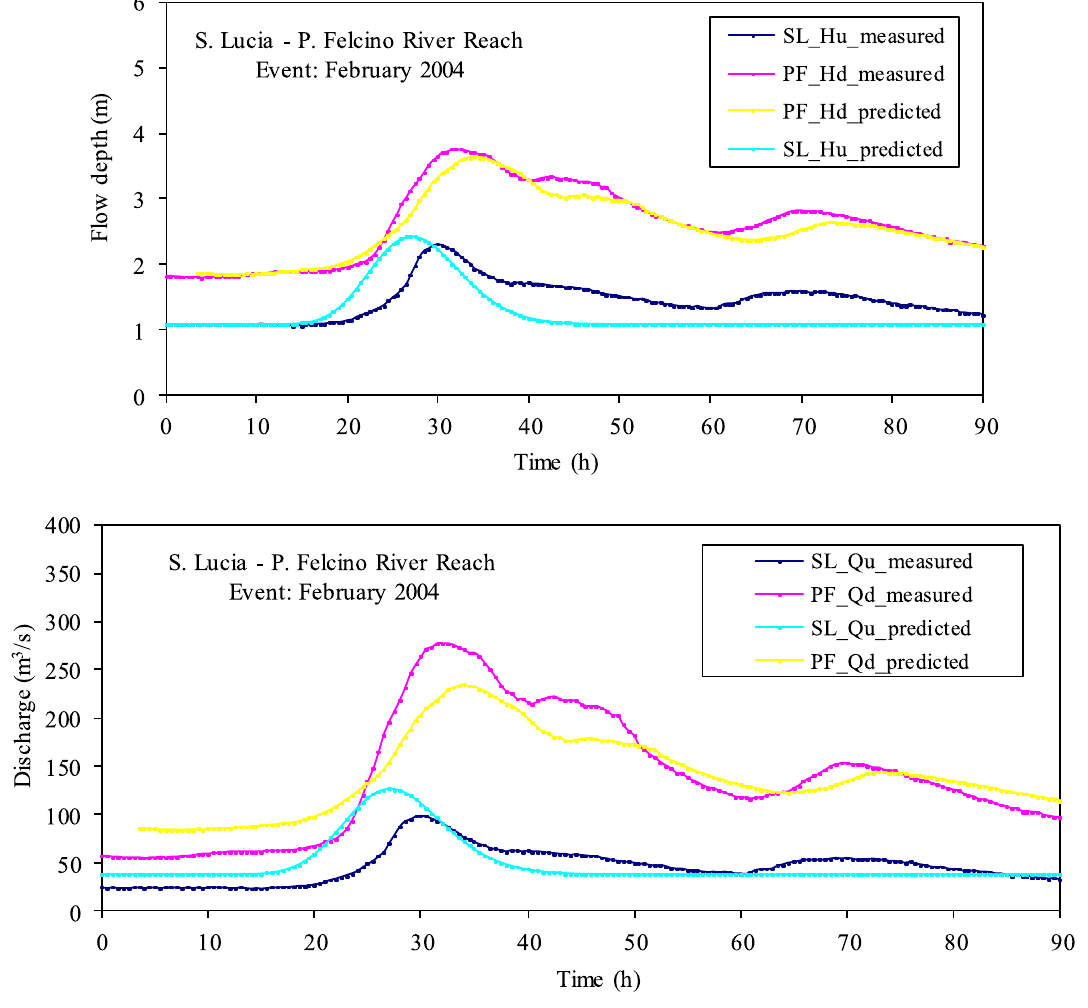
Fig. 3 Flow stage (above) and flow discharge (below) hydrograph simulations for event February 2004 in S. Lucia and P. Felcino river